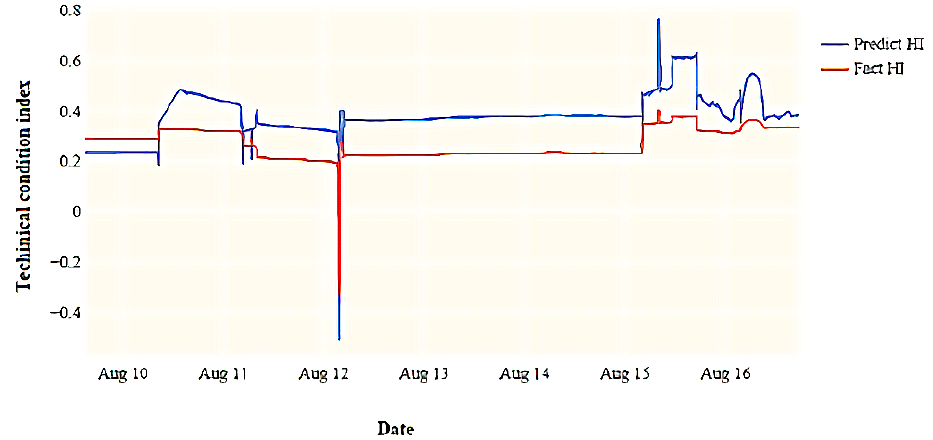
Figure 7. Changes in the predicted values of the technical condition index on the test set in comparison with real data (time shift—3 h).